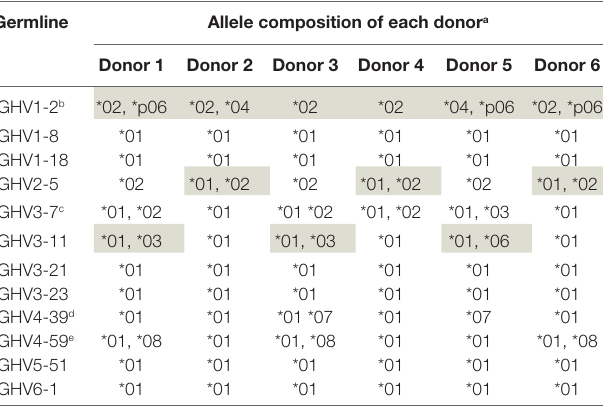
mostly encoded by a single or a few highly related alleles, represent- ing six germline gene subgroups, were selected for further analysis ( Table 1 ). Full-length (all codons from 1 to 105) sequences of func- tional germline genes were downloaded from the IMGT database 1 (release 201718-0). Sequence similarity between these genes/alleles was determined after alignment using the ClustalW algorithm (20) as implemented in MacVector 15.5.0 (MacVector, Inc., Apex, NC, USA). Hot-spots for mutation of individual germline genes/alleles were identified by analysis through use of IMGT V-QUEST